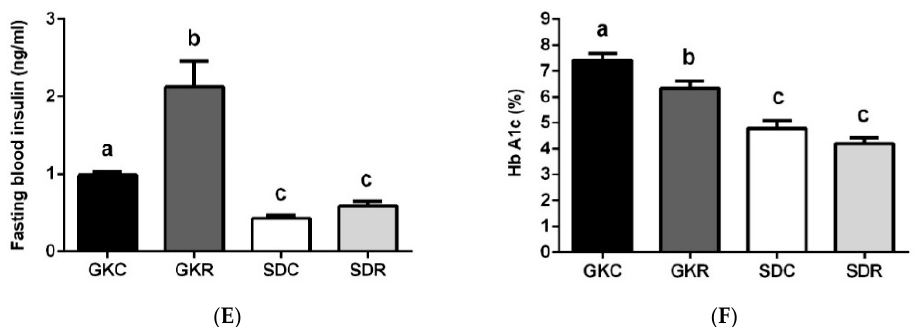
Figure 1. Resveratrol improves glucose tolerance in Goto-Kakizaki (GK) rats. Body weight gains ( A ), time course changes in glycemia after intragastric glucose load ( B ), area under the curve for blood glucose calculated during glucose tolerance test ( C ), fasting blood glucose ( D ), fasting blood insulin ( E ), and glycated hemoglobin (HbA1c) levels in blood of non-fasted rats ( F ). GKC—Goto-Kakizaki control rats, GKR—Goto-Kakizaki resveratrol-treated rats, SDC—Sprague–Dawley control rats, SDR—Sprague–Dawley resveratrol-treated rats. Results are expressed as the means ± standard error of the mean (SEM) from 10 rats in each group. All parameters, except for HbA1c, were measured in fasted rats after eight weeks of the experiment, whereas HbA1c was determined in non-fasted animals after 10 weeks of the study. Values with different letters are significantly different at p <